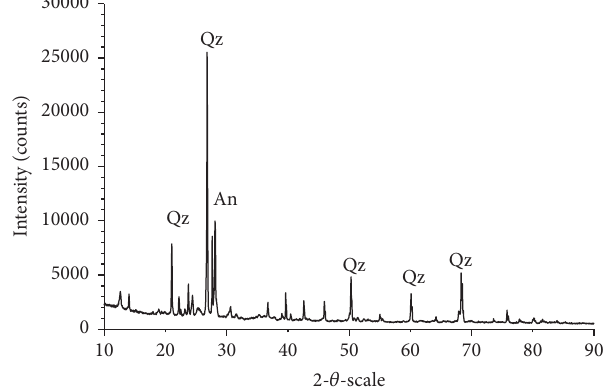
Figure11:X-raydiffractionpowderspectrumofthesandstone.Qz= quartz; An =